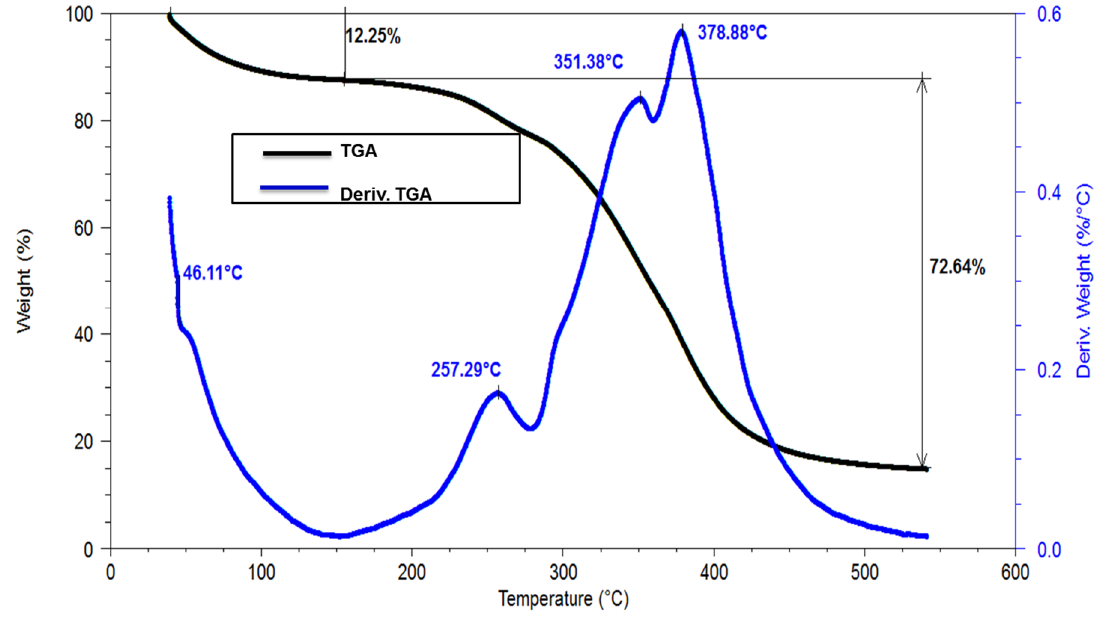
Figure 5. Thermogravimetric analysis of the polyamine ( Polycoat 38 ® ) resin synthesized.